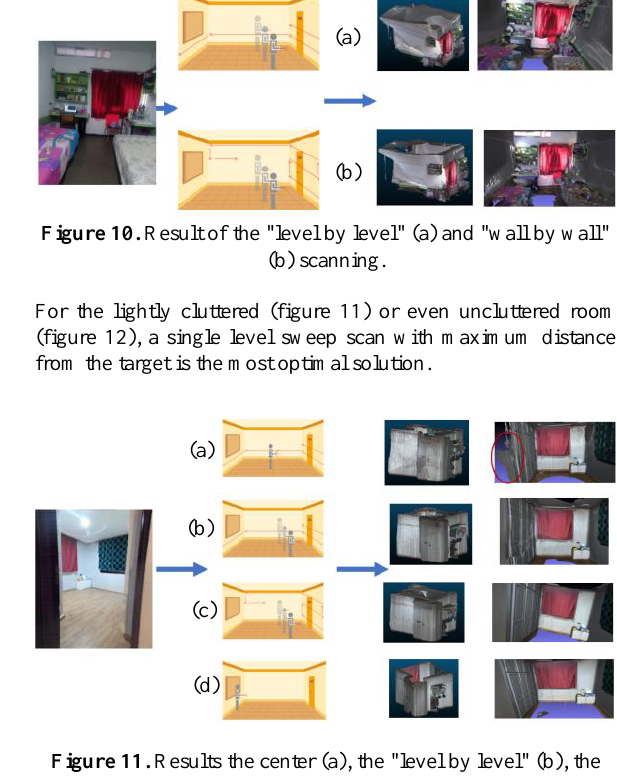
Figure 11. Results the center (a), the "level by level" (b), the "wall by wall" (c) and the single level sweep scan (d), for the lightly cluttered room. Figure 12. Confirmation of the single level sweep method for the uncluttered